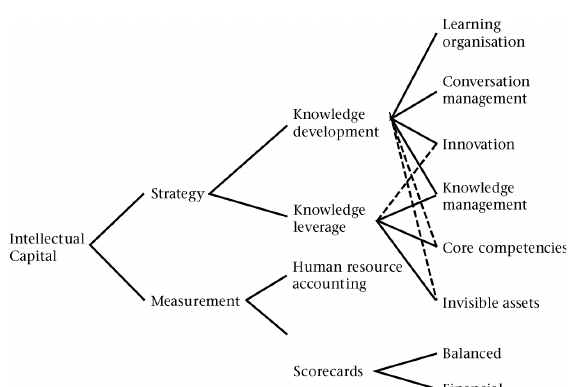
Figure 2: Conceptual Model for the Development of Core Capabilities from an Intellectual Capital